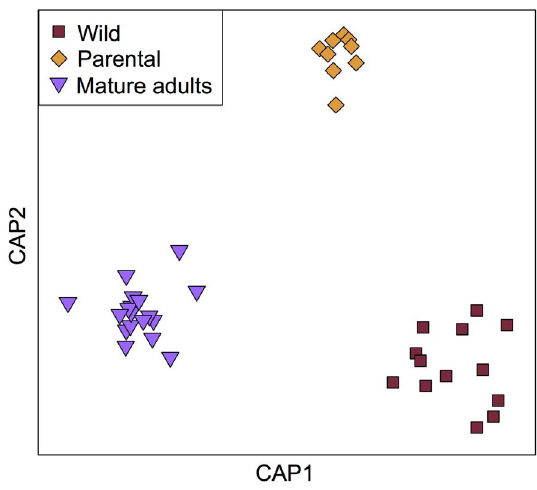
Figure 2. Bacterial community variation associated with captivity and rearing. Constrained principal coordinates analysis showing differences in community composition between adults sampled directly from the wild, wild-caught females kept in an insectary (‘‘Parental’’), and their reared adult offspring (‘‘Mature adults’’). CAP1 and CAP2 are the canonical axes in principal coordinate space that best discriminate among adult groups.